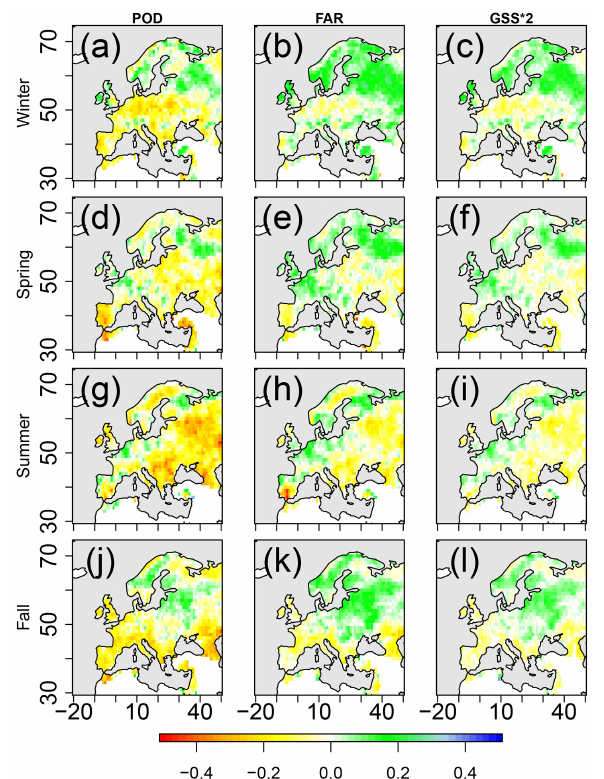
Figure 8. Anomalies of POD (a, d, g, j) , FAR (b, e, h, k) and GSS ∗ 2 (c, f, i, l) of the drought prediction based on the ideal- ized forecasts with regard to the reference forecast, in winter (a–c) , spring (d–f) , summer (g–i) and autumn (j–l) . Improvement scores using the predictors are indicated in green (inverse scale for FAR). Only differences with confidence intervals larger than 90% are plot- ted. GSS is multiplied by 2 to use the same scale as the other met- rics.